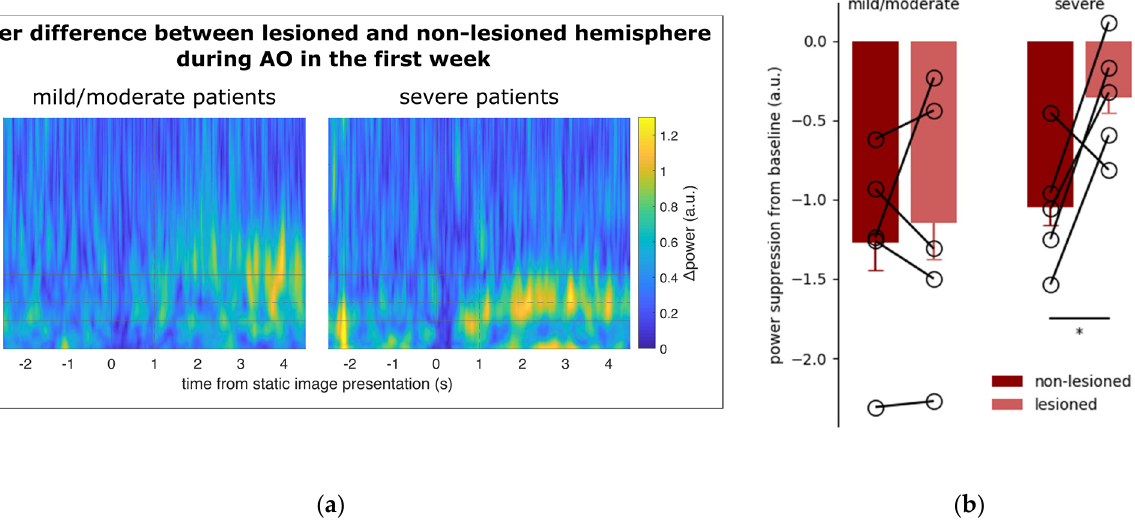
Figure 4. ( a ) Time course of the spectral power difference between the lesioned and non-lesioned hemisphere in patients with mild/moderate (left) and severe motor impairments. The data are aligned at zero with the onset of the still hands (see Methods). The vertical dashed line at +1 s denotes movement onset. The continuous horizontal lines illustrate the frequency band from low- alpha to high-alpha. The dashed horizontal line marks the boundary between low- and high-alpha (i.e., 10 Hz). In patients with severe motor impairment, the power difference between the lesioned and non-lesioned hemispheres is markedly enhanced during action observation, especially in the low-alpha frequency band. ( b ) Power suppression from baseline during action observation in the C3/C4 electrodes positioned over the non-lesioned and lesioned hemispheres of patients with mild/moderate (left) and severe (right) motor impairments. In severe patients, suppression showed a significant asymmetry (i.e., p < 0.05), marked with the asterisk, being more pronounced in the non- lesioned hemisphere. No significant differences were detected in mild/moderate patients. Vertical bars represent SEM. The empty circles connected by sticks indicate data from individual patients.